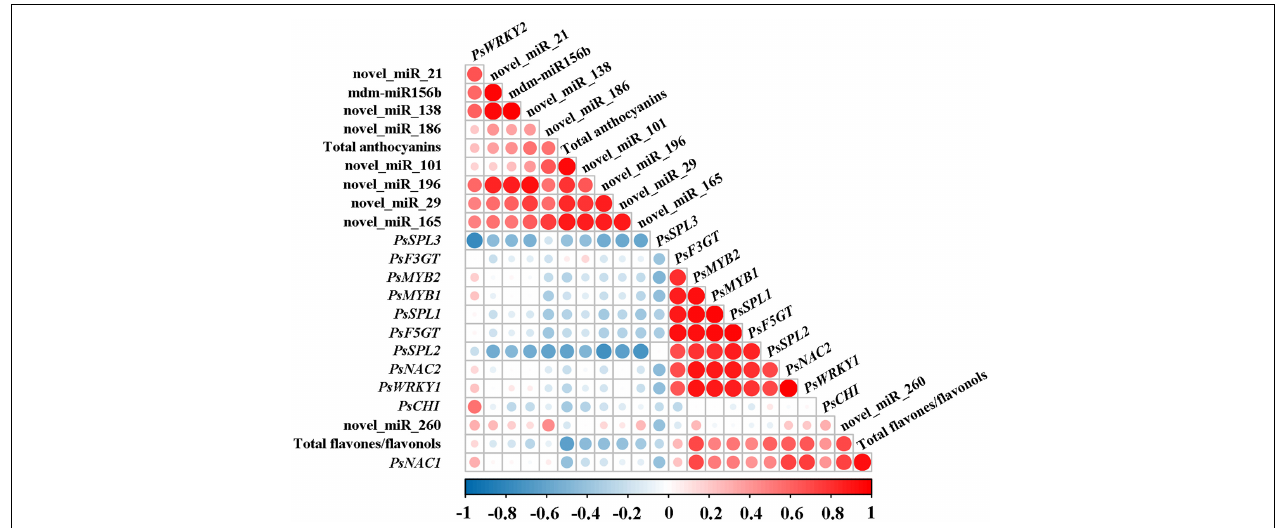
FIGURE 4 | Correlation analysis between the expression of miRNAs and corresponding target genes and the accumulation of total anthocyanins and total flavones/flavonols. Pearson’s correlation coefficients for the data were analyzed using R scripts.